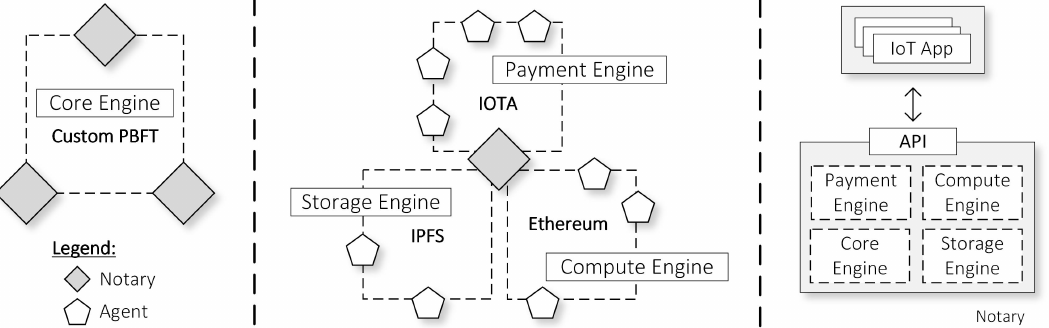
Figure 1. Our proposed hierarchical multi-blockchain architecture for Internet of Things (IoT) environments. The left figure shows the Core Engine that is governed by Notary nodes, the supernodes in our architecture. The middle picture visualizes the Payment, Compute, and Storage Engine as the sub-engines of the Core Engine. Notary nodes, as well as Agent nodes, can connect to these sub-engines. Finally, the right image depicts how IoT applications run on top of the Notary node using the Engine